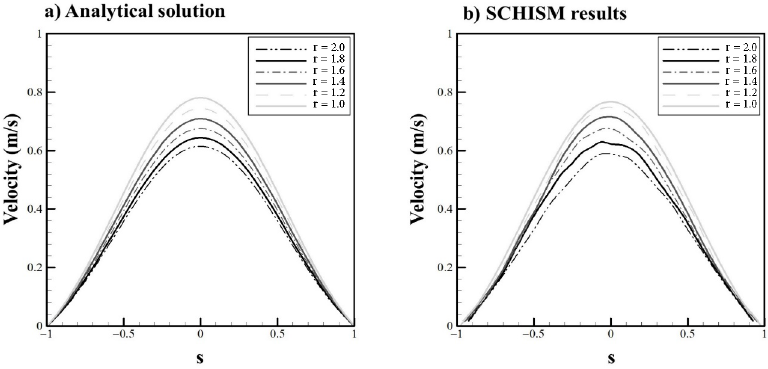
Figure 2. a) Velocity distribution of Analytical Solution, b) Velocity distribution of SCHISM